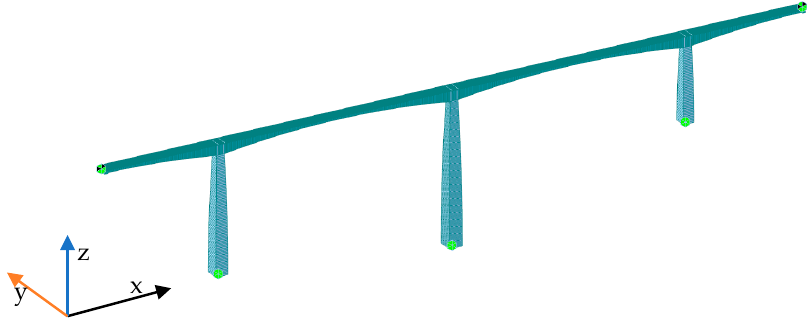
Figure 2. The Tablazo bridge side view.